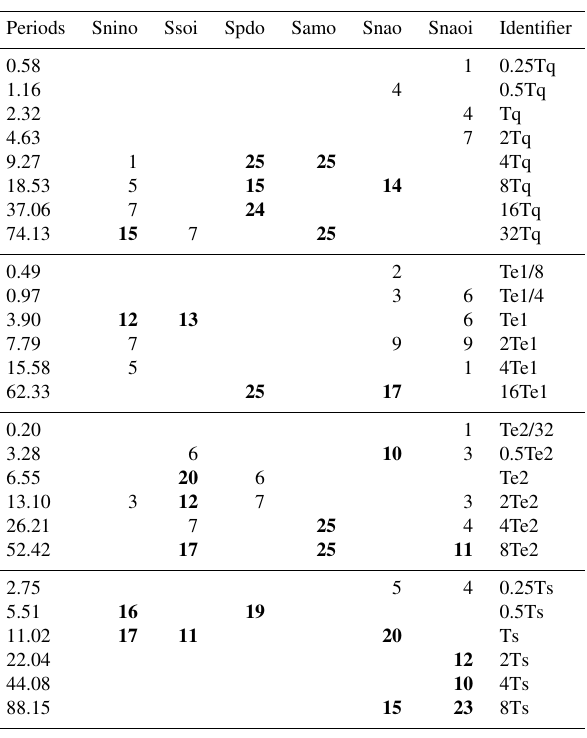
Table 2. The entries show, for each index, the number of embedding dimensions in which a peak period is significant. The left column lists the periods, and the right column shows the identifiers (forc- ings). If the number is greater than 10, it is highlighted in bold.